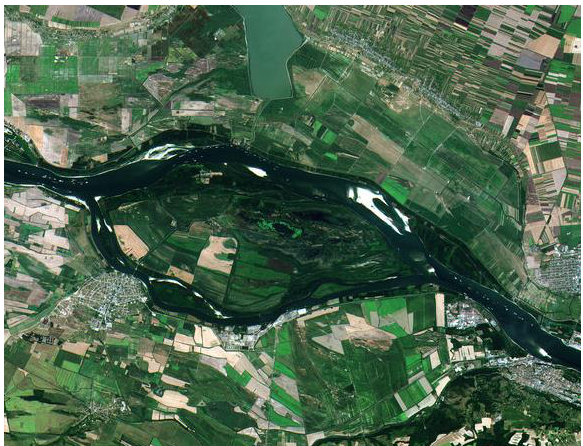
Figure 8. Zimnicea Harbour – 26.07.2015 - Sentinel-2A